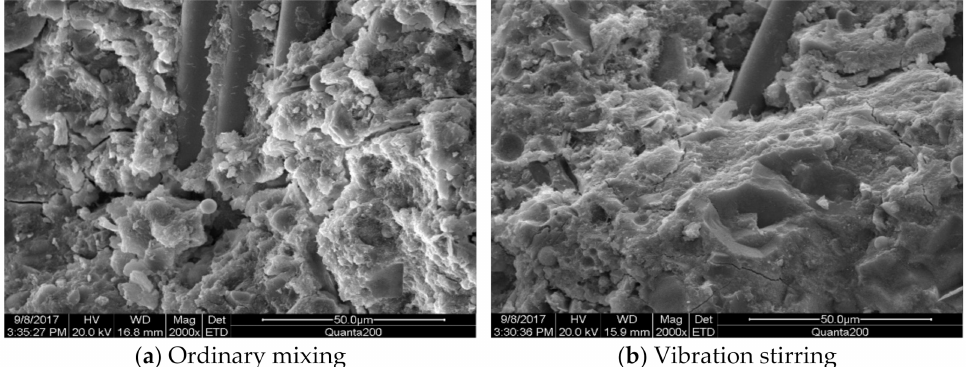
Figure 16. Comparison of morphology of concrete paste with high steel-fiber volume ratio. (Magni- fied 2000 times). ( a ) Ordinary mixing ( b ) Vibration